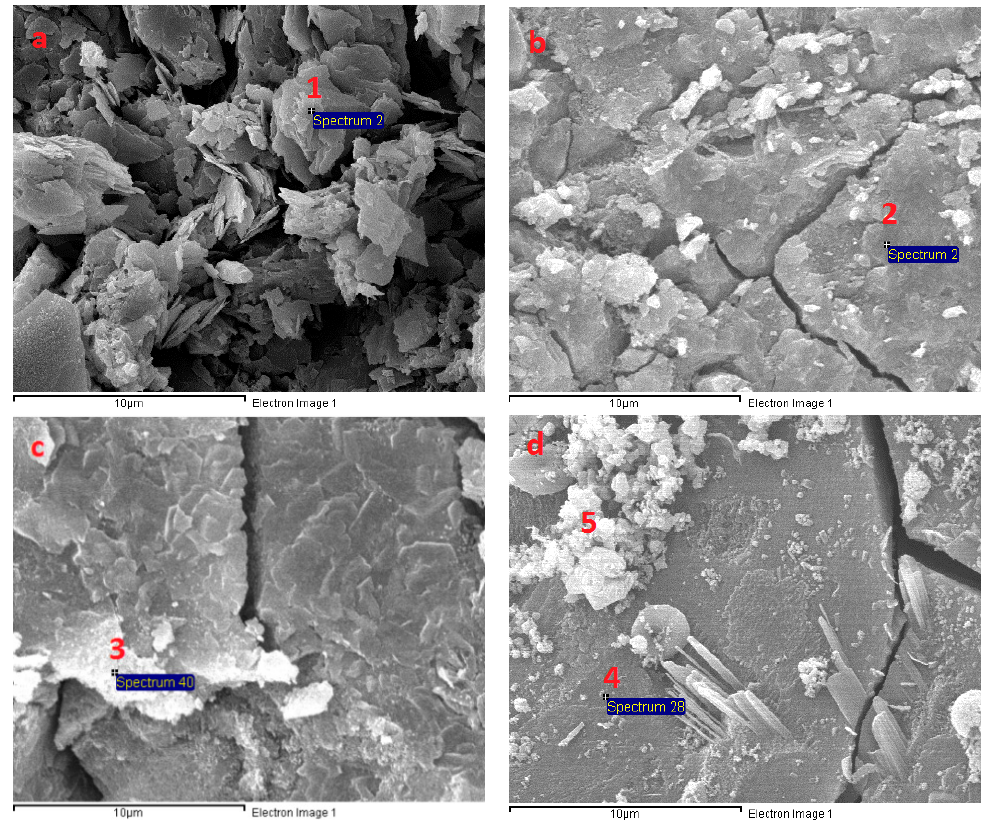
Figure 11. Scanning electron microscopy (SEM) micrograph of fracture surface of AAS mortar at 28 days: ( a ) A4; ( b ) A6; ( c ) A8; and, ( d ) A10.